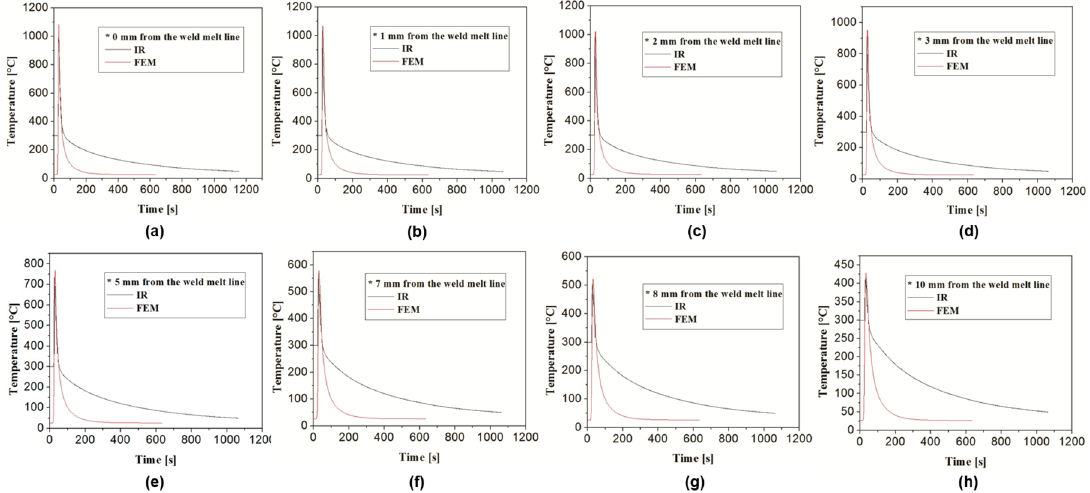
Figure 11. Numerically (FEM) and experimentally (IR) measured thermal cycles and their respective relative distances to the weld melt line: a) 0 mm, b) 1 mm, c) 2 mm, d ) 3 mm, e) 5 mm; f) 7 mm, g) and h 8 mm) 10 mm